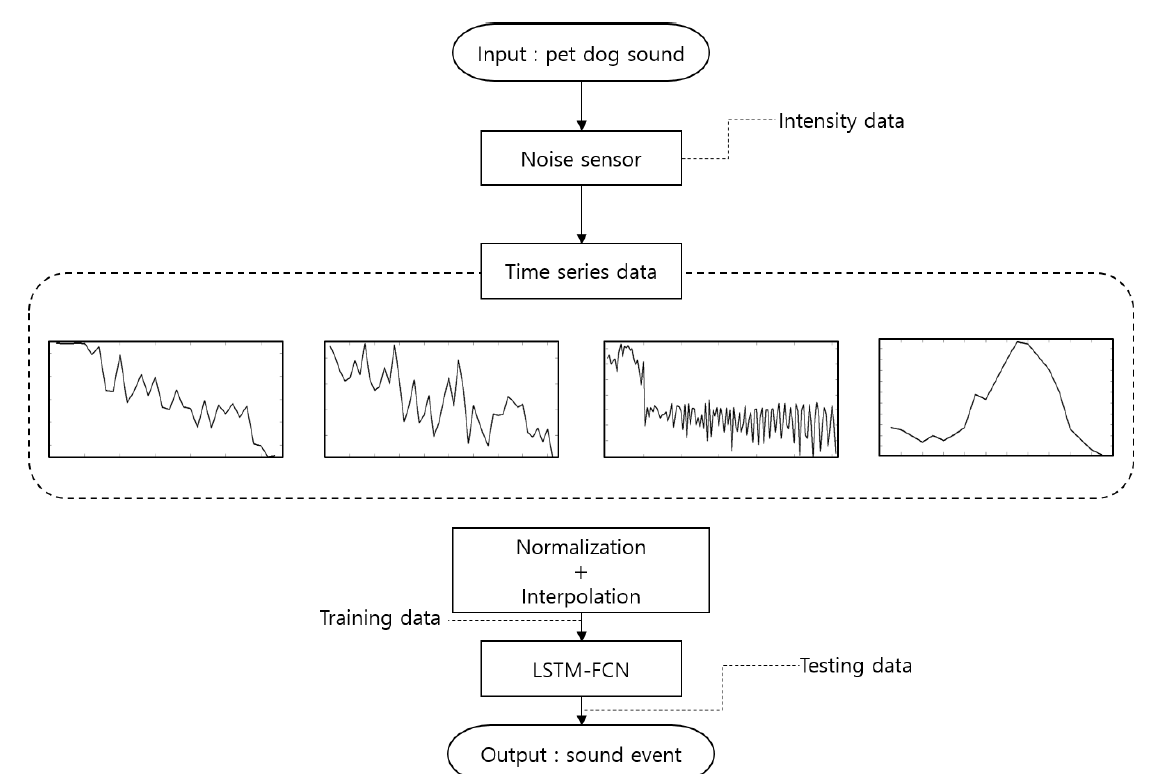
Figure 1. Overall structure of the proposed method.